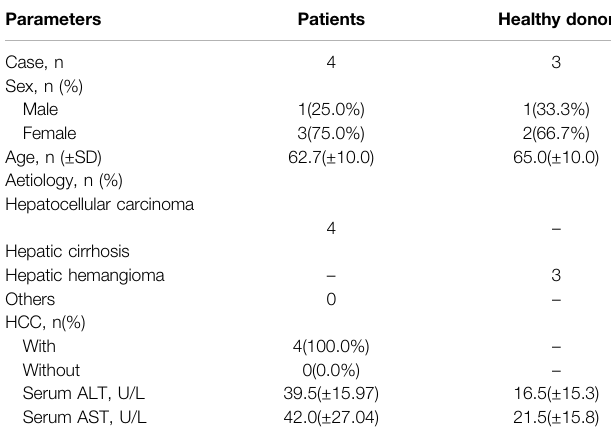
TABLE 2 | Clinical characteristics of